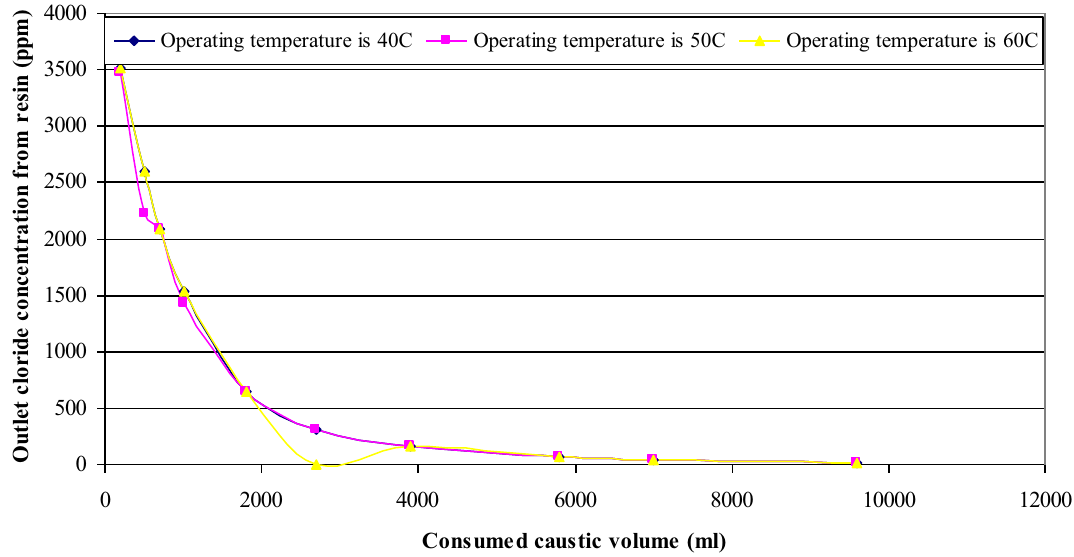
Fig. 3 Caustic volume passing through the resin versus chloride concentration leaving the resin